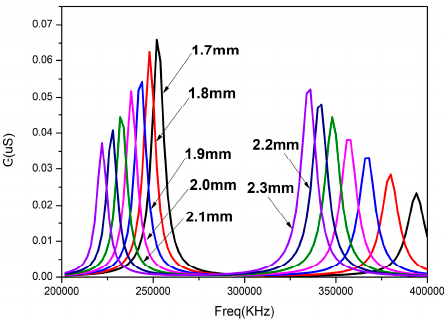
Figure 6. The conductance curves of sensitive component with different thickness matching layers.